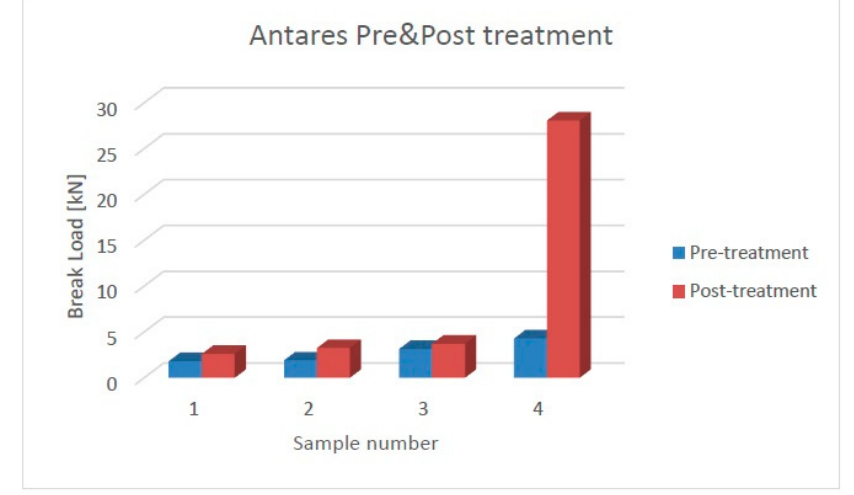
Figure 12. Antares pre- and post-treatment samples compression strength.